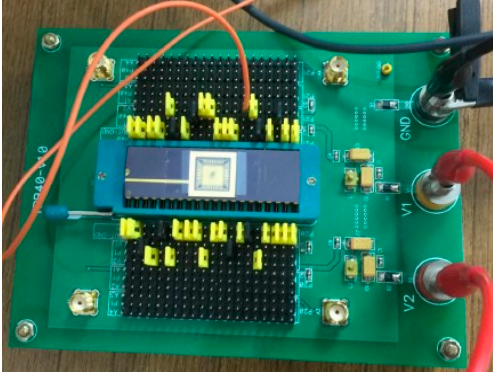
Table 2. Measurement results of step/range of tuning stage.